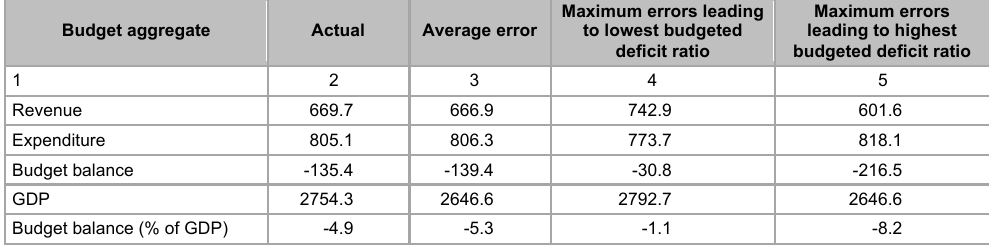
Counterfactual budget estimates for 2010/11 based on different error scenarios (R